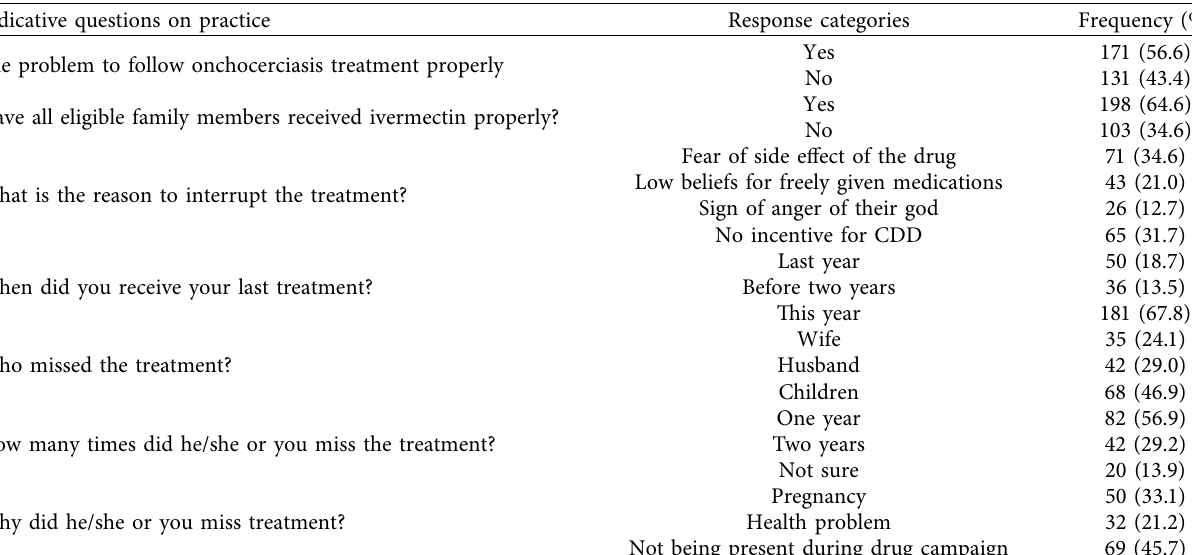
Table 5: Practice of the community to the success of elimination program of onchocerciasis from Gesha town, Ethiopia. Indicative questions on